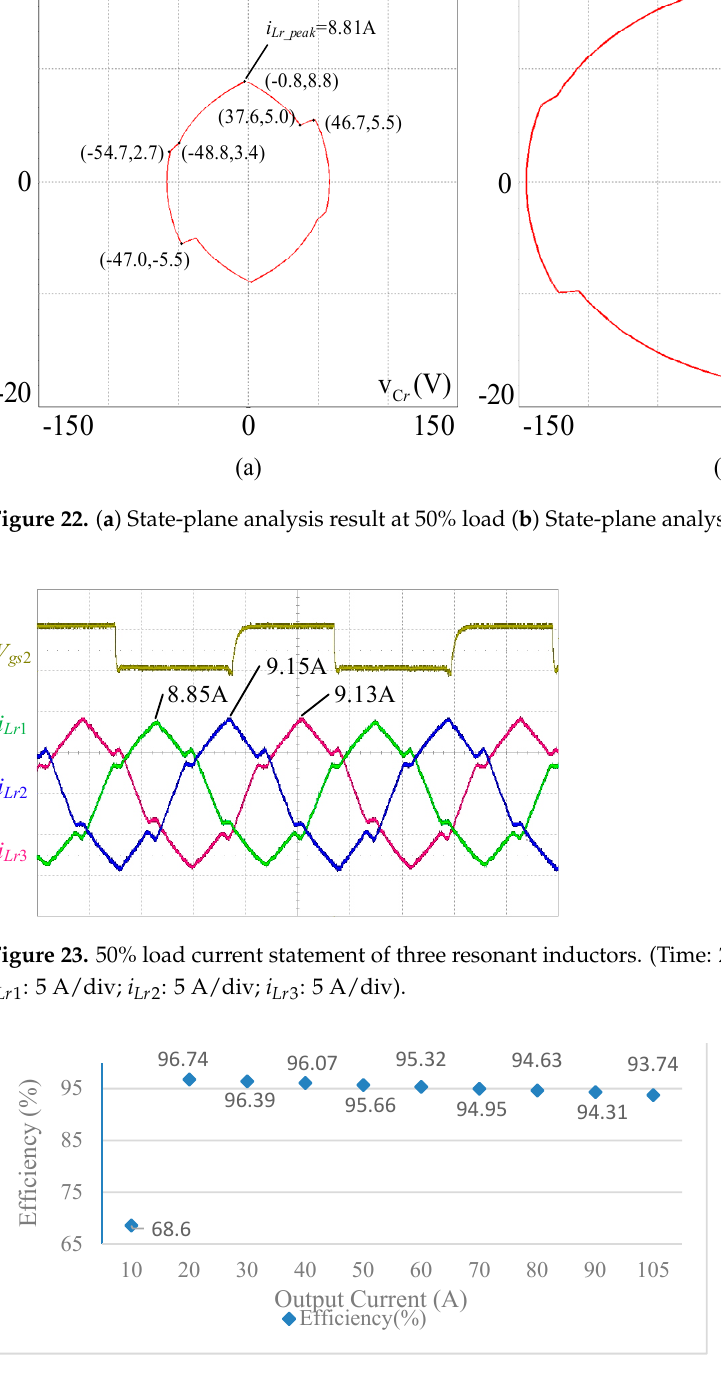
Figure 24. Efficiency of three-phase wye–delta LLC.